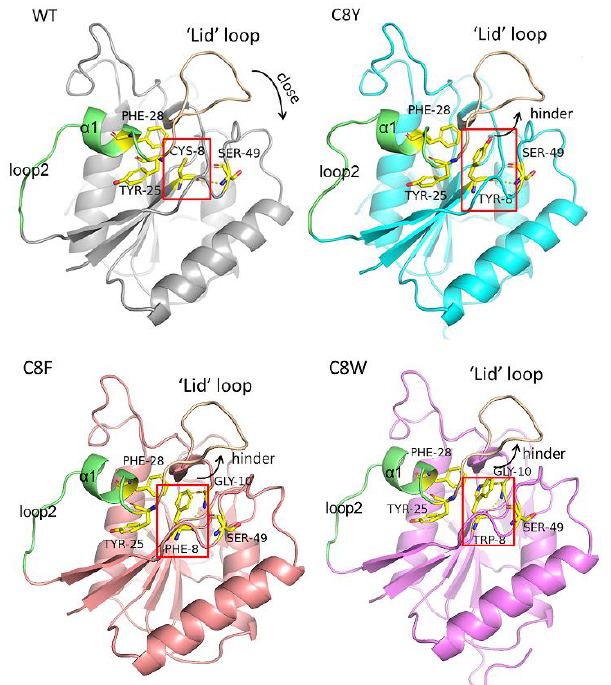
Figure 6. Structures comparison around residue 8 in AsA wild-type and its mutants.